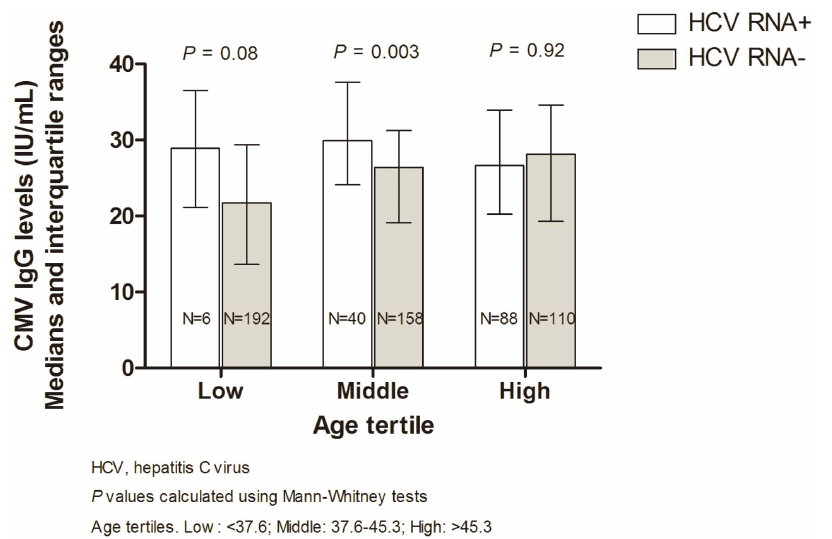
Figure 1. Median CMV IgG (IU/mL) by HCV RNA status and age tertile in CMV-seropositive women (N=594).